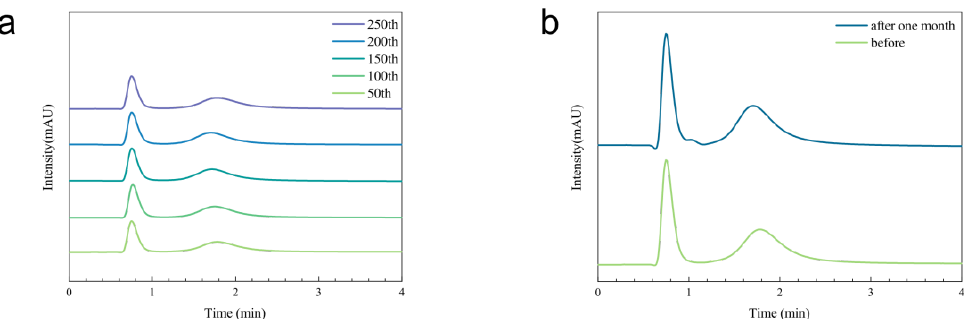
Figure 5. The chromatograms of DL-alpha-methylbenzylamine on the MIL − 101 − Ppa@SiO 2 packed column after repeated injections: (1) 20th, (2) 40th, (3) 60th, (4) 80th and (5) 100th injection ( a ) and the injections before and after one month ( b ).